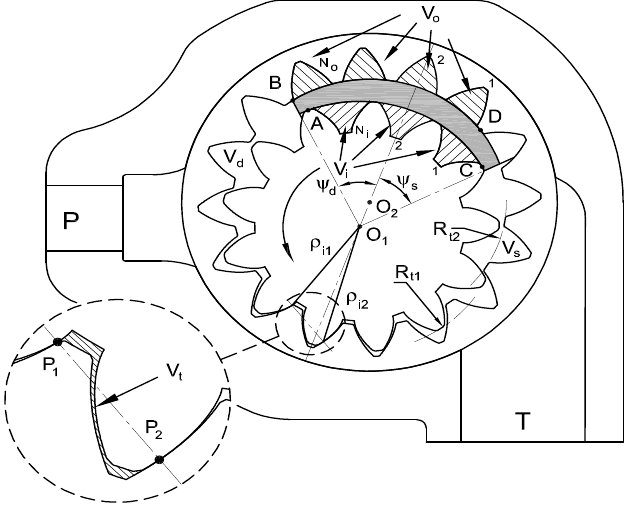
Figure 2. Definition of the control volumes.